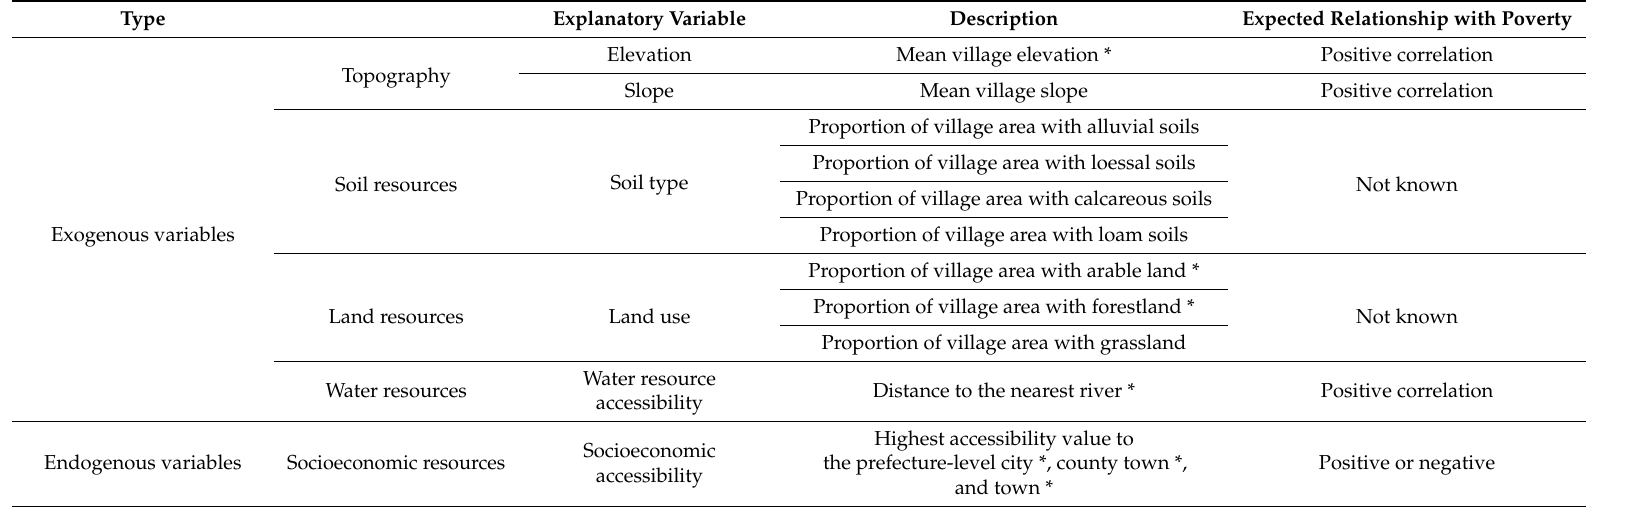
Table 1. Potential factors influencing rural